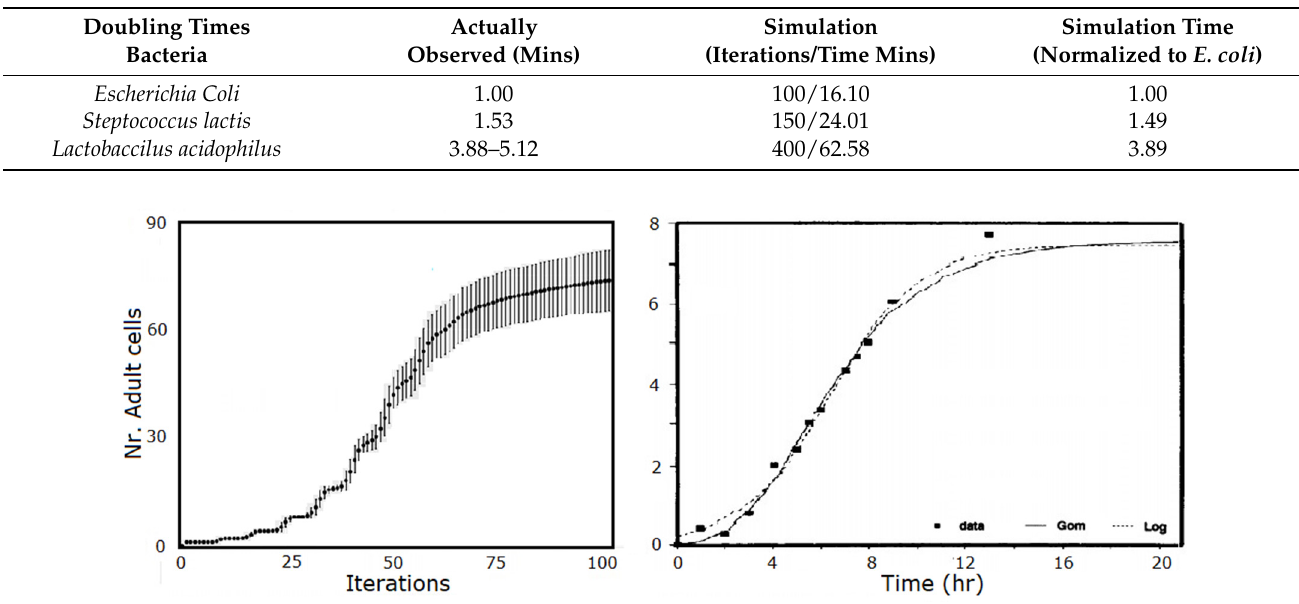
Figure 3. Growth profile of simulated bacterial cells in M bac ( left ). The x -axis is the number of iterations simulations (with stds). From the results in Table 2, one iteration corresponds to 1 min in real time. The right figure shows the results fitted on L. Plantarum data with the Gompertz and logistic models, considered the best prototypes according to [41].